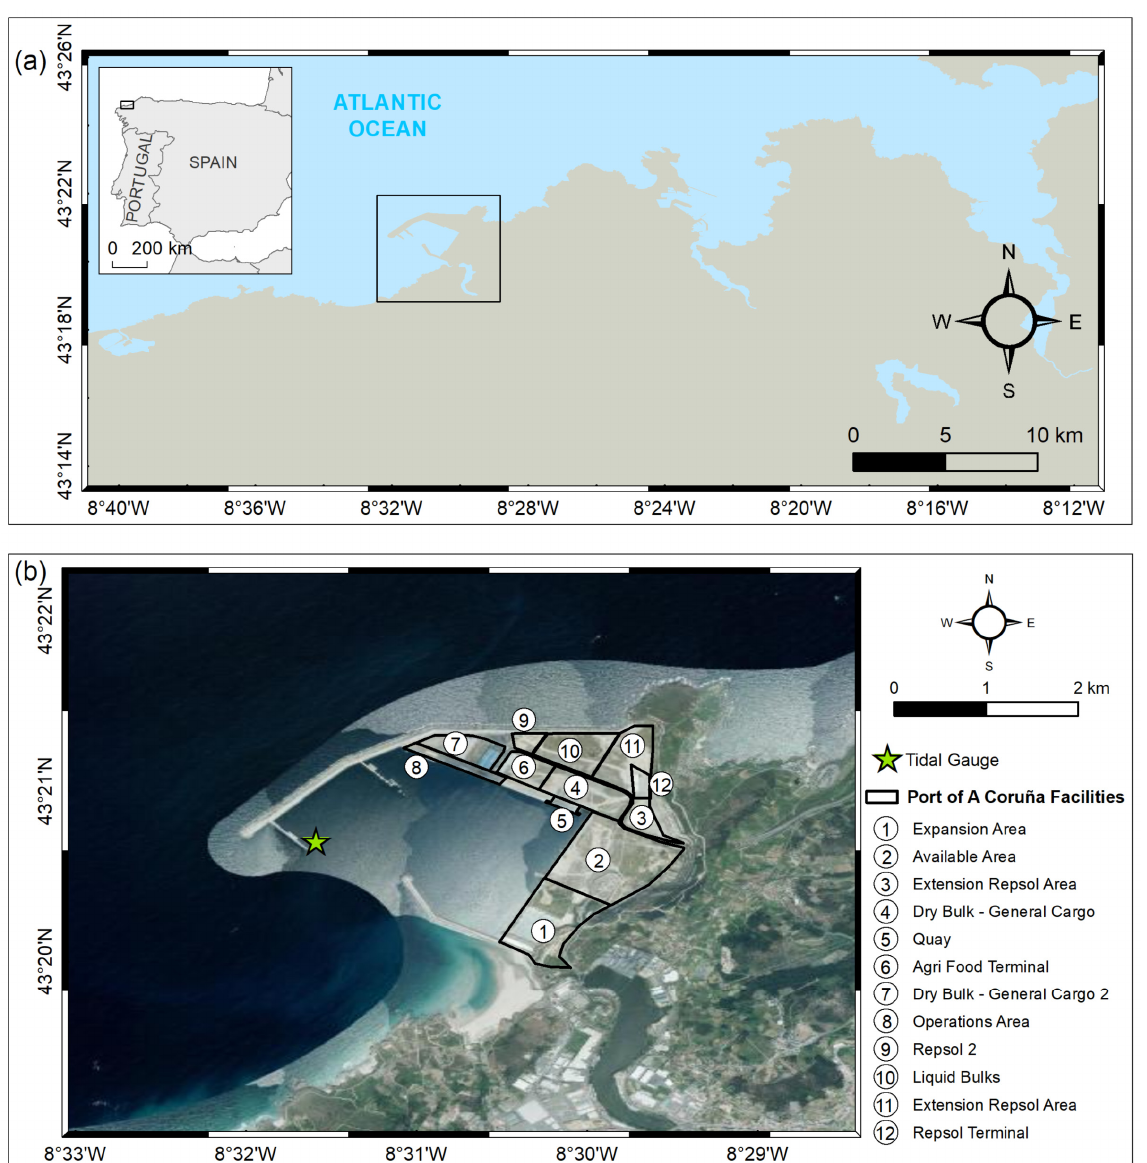
Figure 2. Study area and location of the A Coruña Outer Port ( a ) and the business areas ( b ).